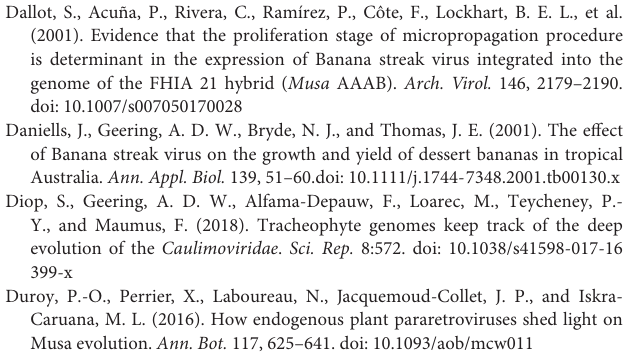
Supplementary Figure 1 | Location of the collection sites used for the prevalence survey. Blue, red and gray triangles represent locations where BSGFV-, BSOLV- and non-infected samples were collected, respectively. Supplementary Figure 2 | Map of the experimental plot used to study the activation of eBSOLV and eBSGFV infectious alleles under field conditions in cultivars French Clair and Pelipita. Random blocks are delimited by thick lanes. Cultivar ∗ multiplication mode combinations that were used to replace missing combinations are shown in red. Color codes used for each combination are the same as those used in Supplementary Table 4 . Supplementary Figure 3 | Kinetics of activation of eBSOLV and eBSGFV infectious alleles in cultivars French Clair and Pelipita measured over a 24 months period in the experimental plot. Color codes used for each combination are the same as those used in Supplementary Table 4 . BSV species detected in plants are specified: OL (BSOLV) and GF (BSGFV). (A) 3 months after planting; (B) 6 months after planting; (C) 9 months after planting; (D) 12 months after planting; (E) 15 months after planting; (F) 18 months after planting; (G) 21 months after planting; (H) 24 months after planting. Supplementary Figure 4 | Location of the experimental plots used for the multi-site assessment of the activation of infectious alleles OL1 and GF7 in cultivar French Clair. Supplementary Figure 5 | Percentage of BSOLV- and BSGFV-infected samples collected during the prevalence survey from plants with an AAB genotype (French Clair, Figue pomme). Percentages of infected samples were distributed according to the altitude of the sampling